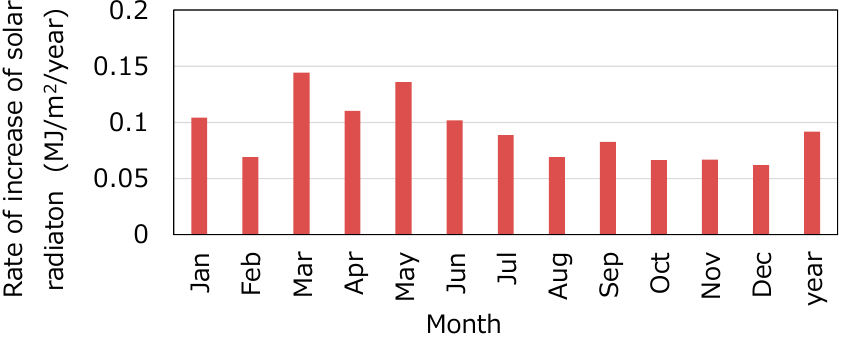
Figure 14. Rate of increase over time in the monthly average of solar radiation for each month. Solar radiation: same as Figure 13. Rate of increase in solar radiation: slope of linear regression line for the monthly average for each month over 30 years.